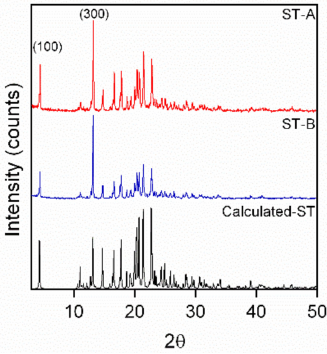
Figure 3. Overlay of PXRD patterns of ST-A, ST-B, and calculated